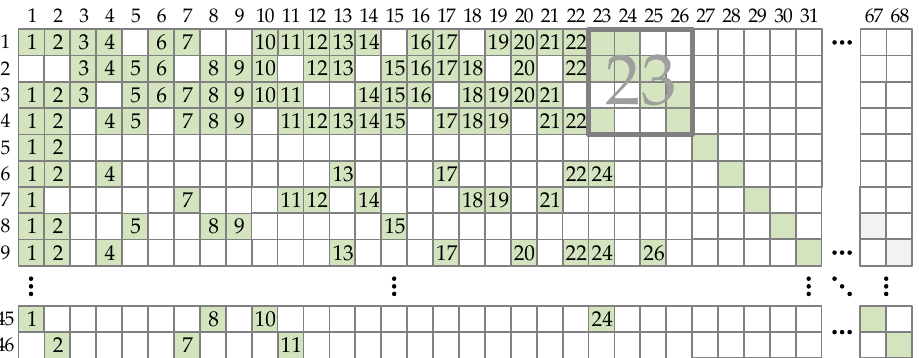
67 68 Figure 2. Encoding schedule for BG1 codes when serially processing single CPM at a time. Numbers represent the ordinal of the clock cycle in which the corresponding CPM is processed. The encoding throughput can be increased if a larger number of parallel processing units is used, i.e., by exploiting higher parallelism. Figure 3 shows the encoding schedule proposed in [34] for Wi-Fi codes but here applied to 5G NR codes. All CPMs that belong to a single column are processed in parallel. After the first k b columns are processed, all λ vectors are ready and core parity bits can be calculated. It is convenient to wait at least